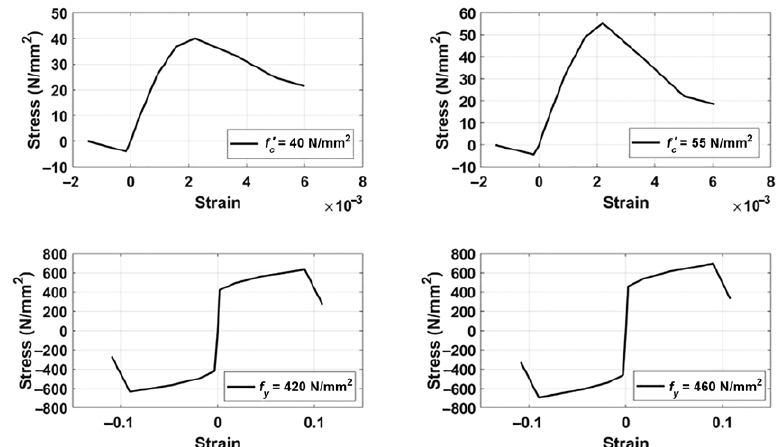
Figure 4. Stress–strain relationship of concrete and reinforcing steel under tension and